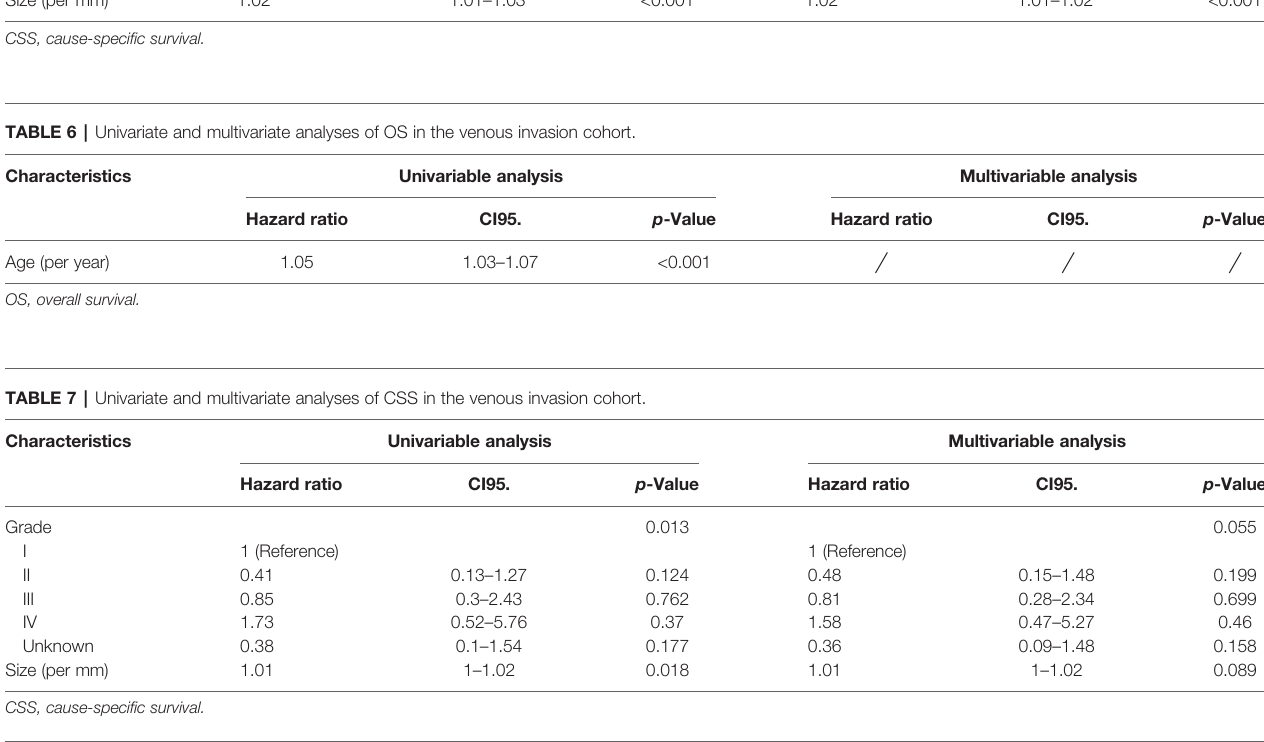
TABLE 8 | Association of nephrectomy type and survival (partial nephrectomy is reference).